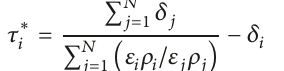
Elasticity of the utility function of flight i. Used